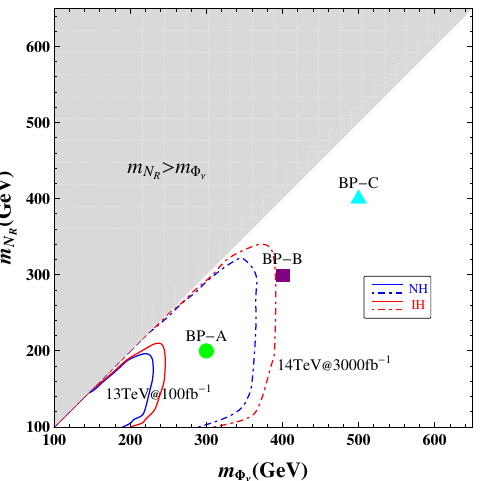
Figure 12 . The expected 95% C.L. exclusion limits in the m N at LHC13@100 and